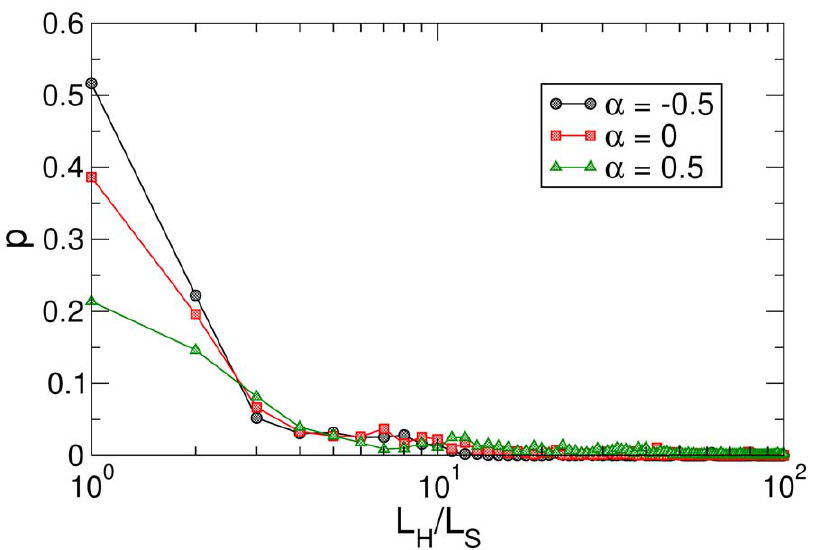
doi:10.1371/journal.pone.0043694.g002